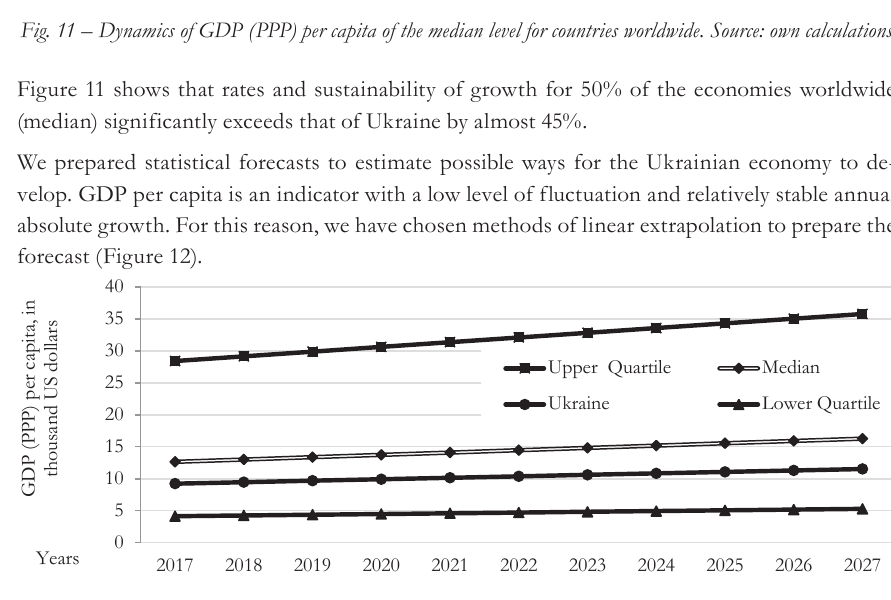
Fig. 12 – The forecast of GDP (PPP) per capita growth. Source: own